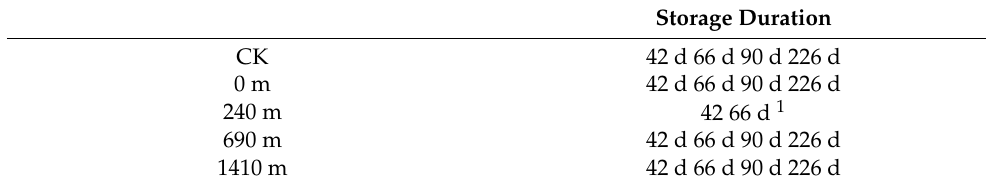
Table 1. Durations of seed storage at different depths in the deep